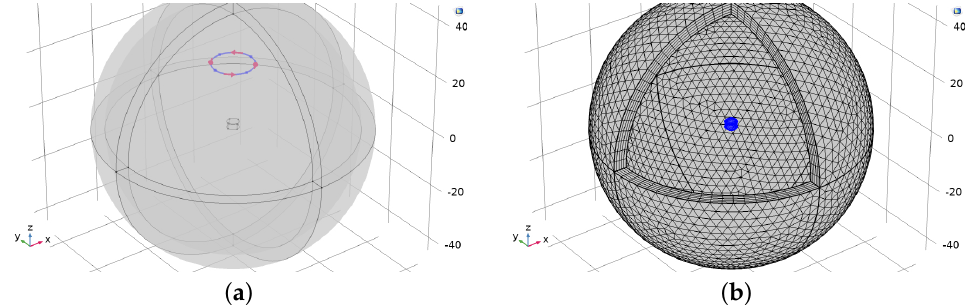
Figure 3. Diagrams of the 3D finite element model (COMSOL) showing ( a ) an object at the origin, the primary coil, and the boundary layer; and ( b ) the free tetrahedral elements for the object and for the finite domain employed in this study.